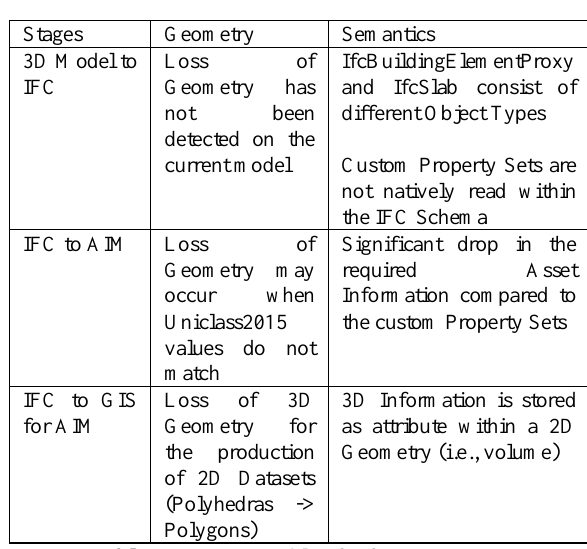
Table 3 . Summary Table of Information